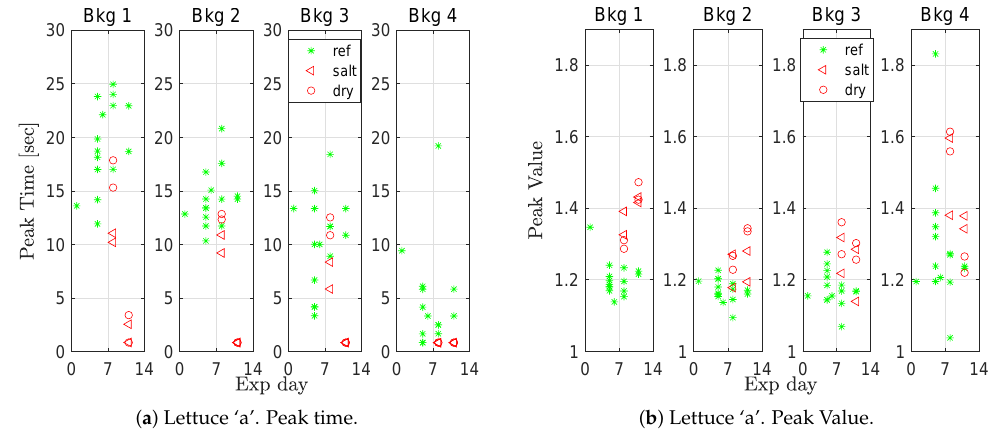
Figure 5. Peak time ( a ) and peak value ( b ) of the responses at all four background light levels for healthy (ref) as well as the salt- and drought-stressed lettuce ‘a’.